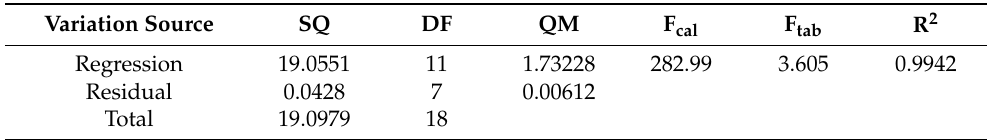
Table 6. ANOVA and coefficient of determination of the factorial design of organo-functionalized sample with the variable (Q t ).